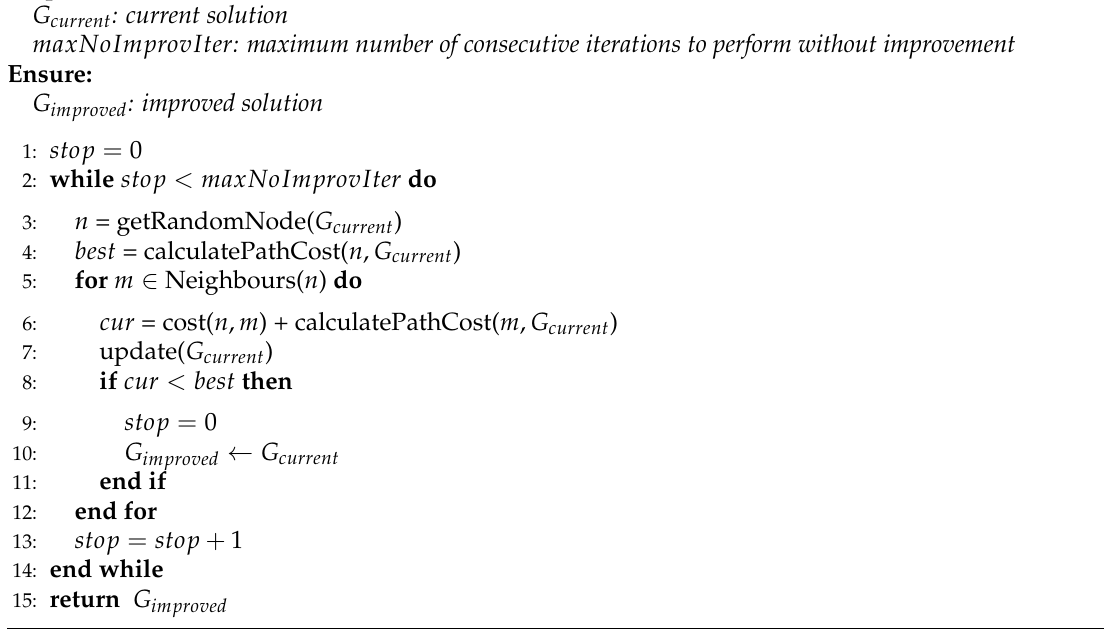
Algorithm 3 localSearch ( G current , maxNoImprovIter